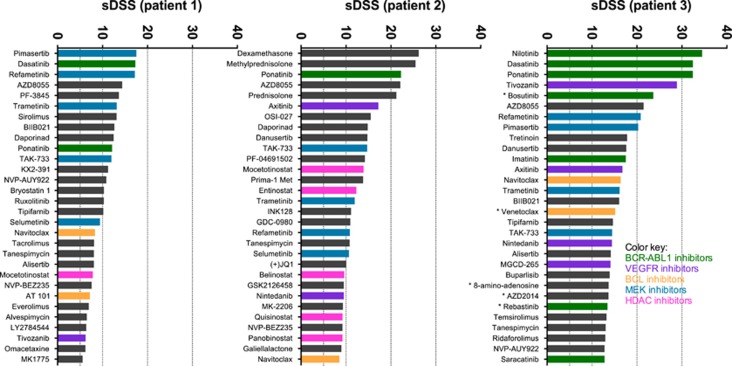
Top 30 selective DSS (sDSS) in patient samples without conventional cytostatic and cytotoxic drugs. Drugs denoted with asterisk were tested only in patient sample 3.